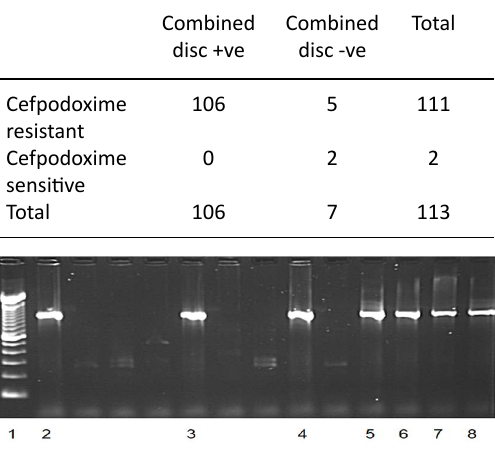
Fig. 1. PCR results of bla CTX-M positive isolates. Lane 1: Lambda DNA of a multiple 100bp size marker. Lanes 2 to 10: bla CTX-M positive isolates. Lane 11: negative control. Lane 12, 13: positive controls.